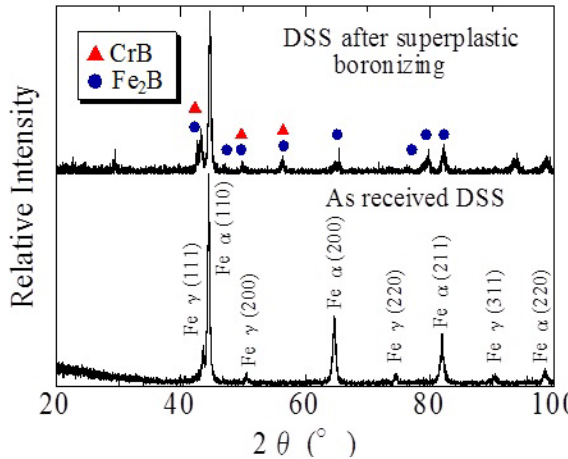
Figure 13. X-ray diffraction pattern of boronized SPDSS [15].